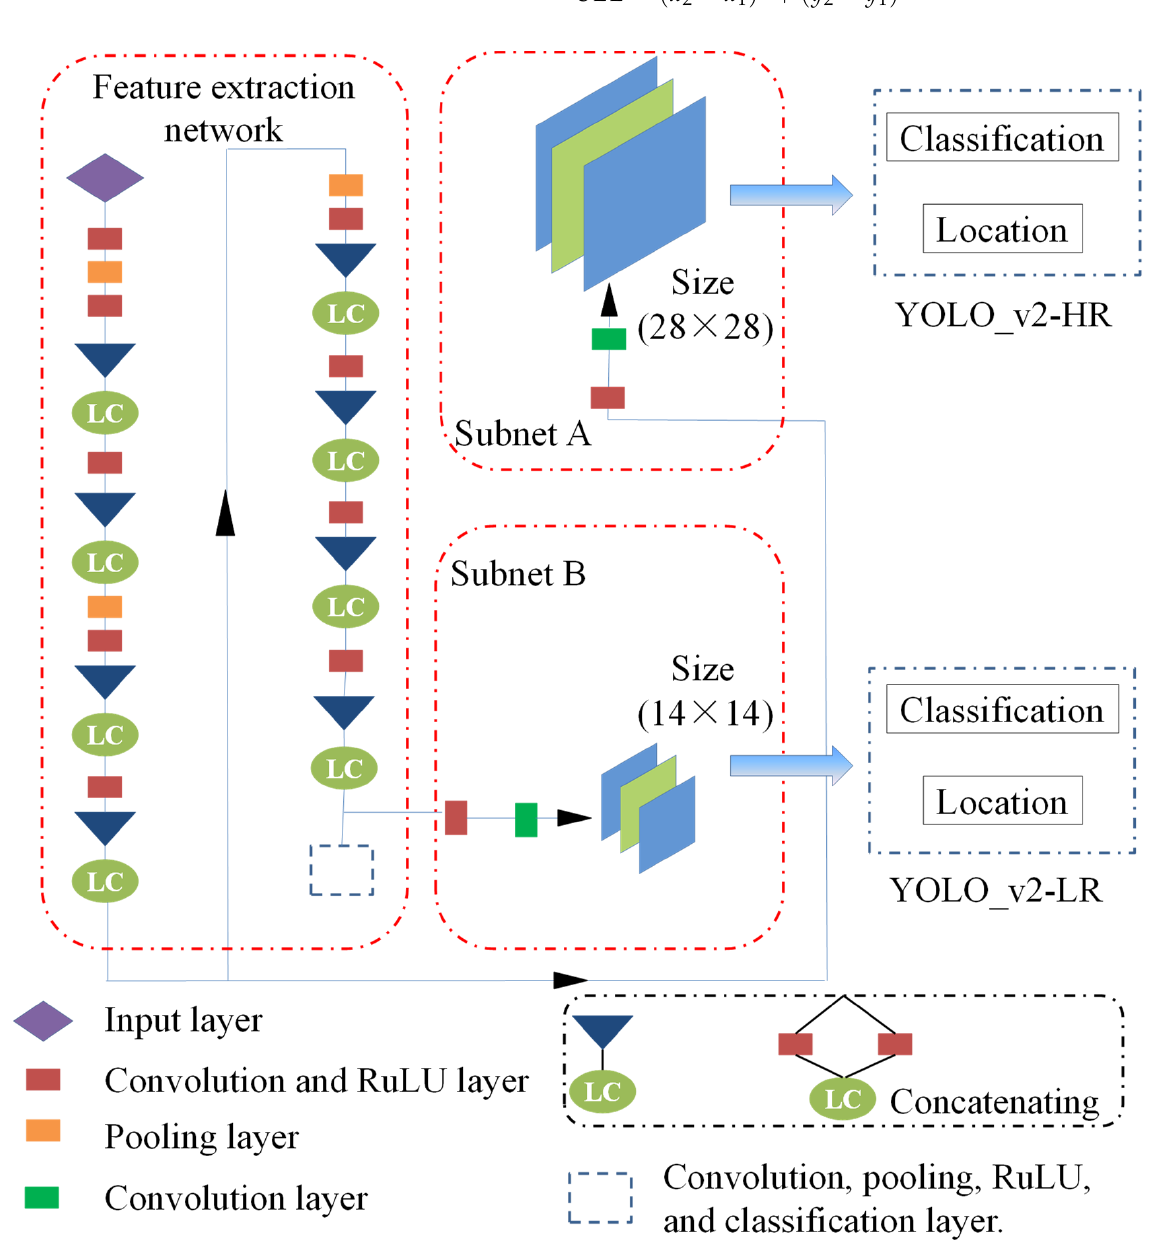
Figure 3. The YOLOv2 architecture. The subnet of the YOLOv2 uses anchor boxes to detect the location and classification of the defined object. Each anchor box can extract a subimage from the original image, and each subimage can obtain a large number of feature images after the convolution layer. These feature images can obtain the category through the classification layer and obtain the location through the regression layer (the detection process of each anchor box is independent). The use of anchor boxes improves the performance for the detection pro- cess of an object detector [30] to detect objects in an image, and the selection of anchor boxes was realized by an automatic evaluation function (‘estimateAnchorBoxes’) of MATLAB (https://ww2.mathworks.cn/help/vision/ref/estimateanchorboxes.html, No- vember 14, 2021). During detection (Figure 4), the feature images obtained by the feature extractor were used as the input of the subnet and then the anchor boxes were labeled into the image, and the mapping relationship between the anchor boxes and the defined image labels was formed through the neural network (the detection layer in Figure 4) composed of two convolution layers. The location error was gradually by reduced using minimizing the loss function. As shown in Figure 4, the coordinates of the predefined anchor box were ( x 1 , y 1 ), and those of the refined anchor box were ( x 2 , y 2 ). During training, the precise loca- tion of the anchor box was obtained by minimizing the loss function (squared error loss,